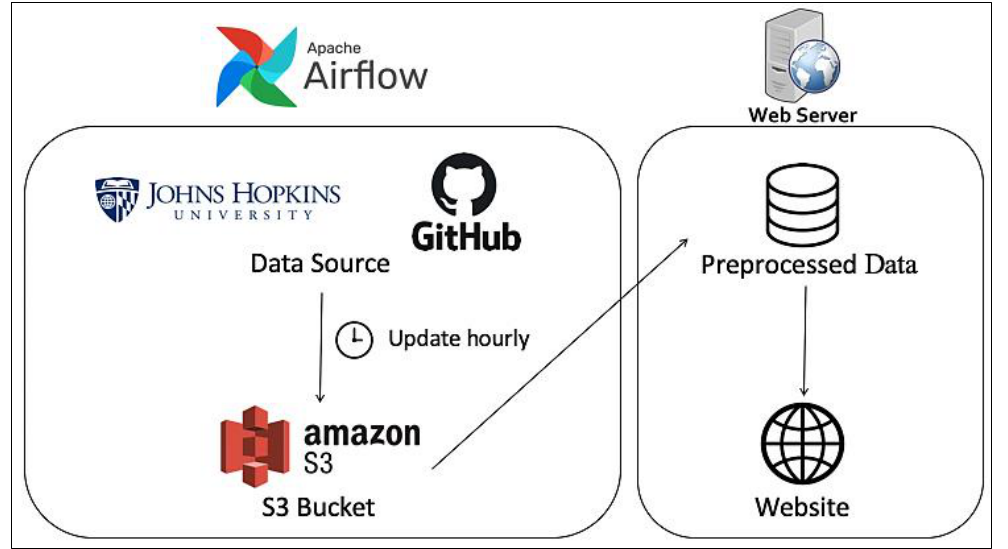
Figure 6. Automatic Data Ingestion Pipeline